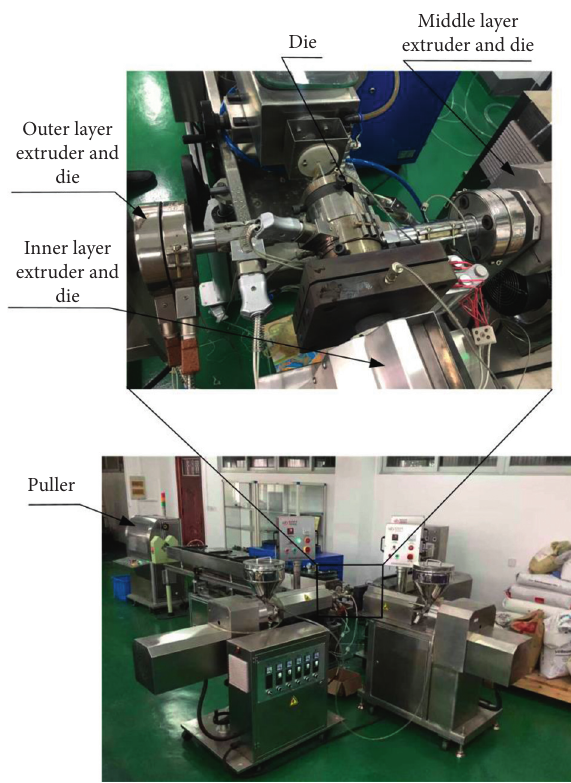
Figure 3: Microextrusion system.